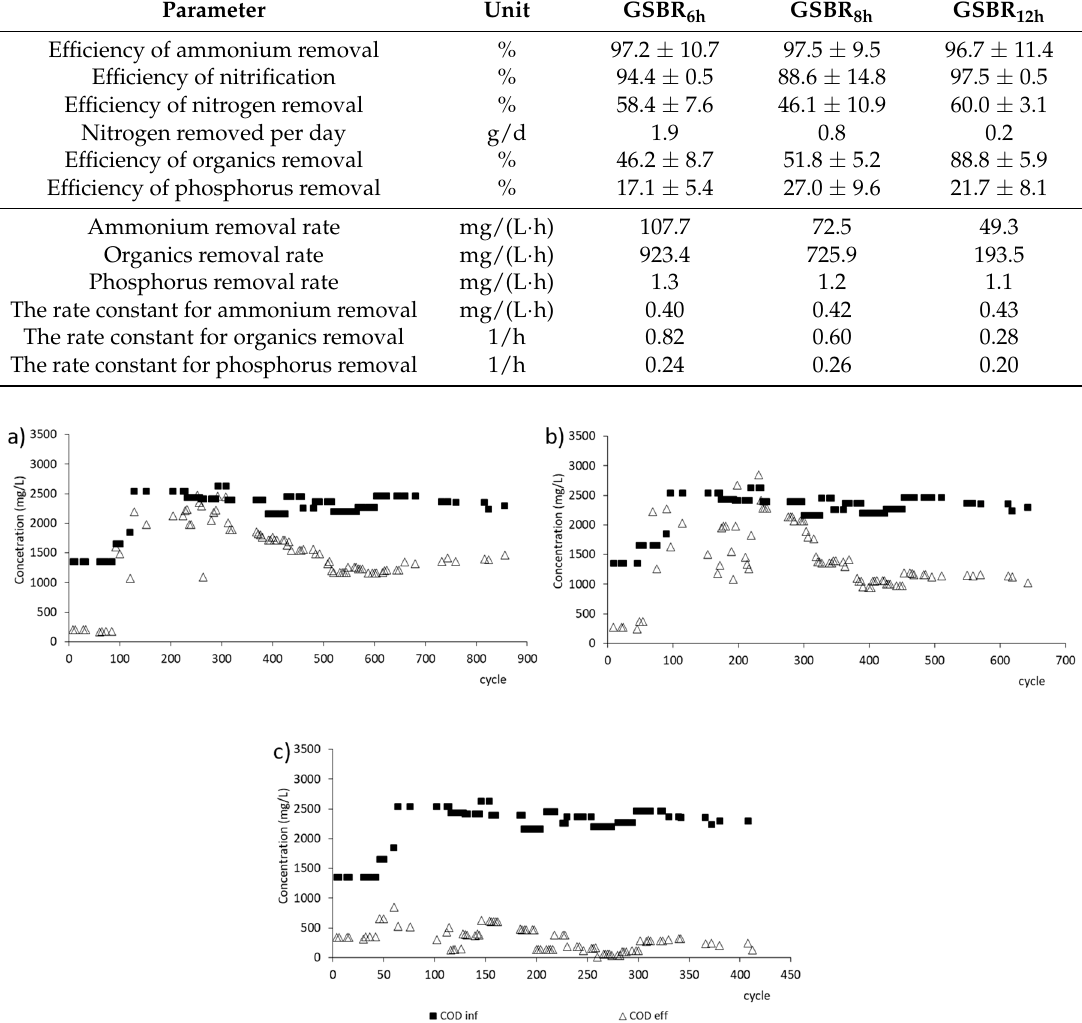
Figure 1. Concentration of organics in the influent (COD inf ) and effluent (COD eff ) for GSBR 6h ( a ), GSBR 8h ( b ), and GSBR 12h ( c ).